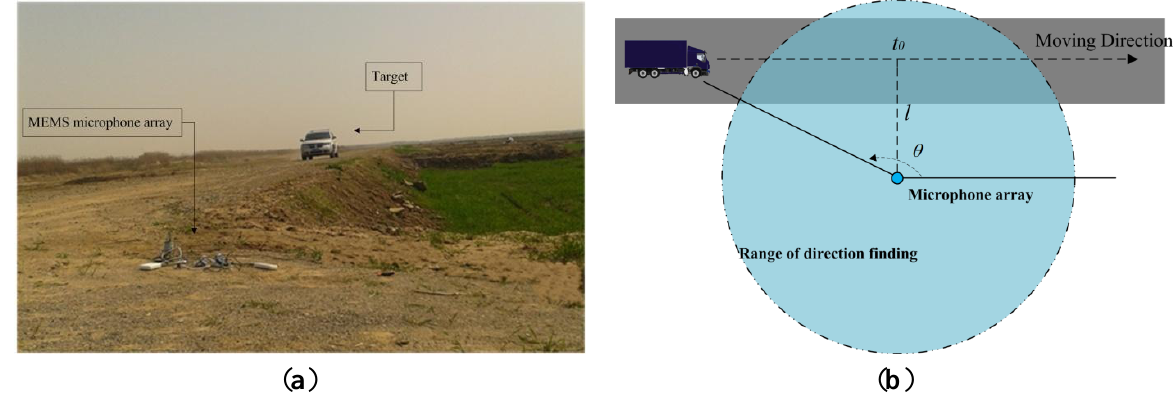
Figure 8. ( a ) Photograph of the experimental environment; ( b ) A schematic diagram of the direction finding